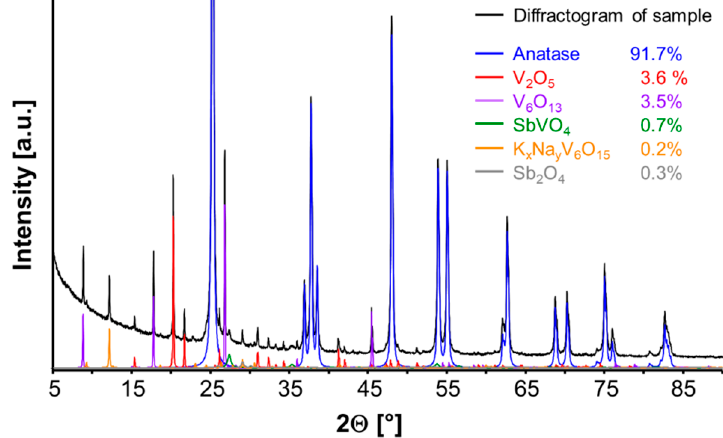
Figure 5. Exemplary X-ray diffractogram of sample from bottom (L4) of one respective reactor tube, combined with its Rietveld refinement.